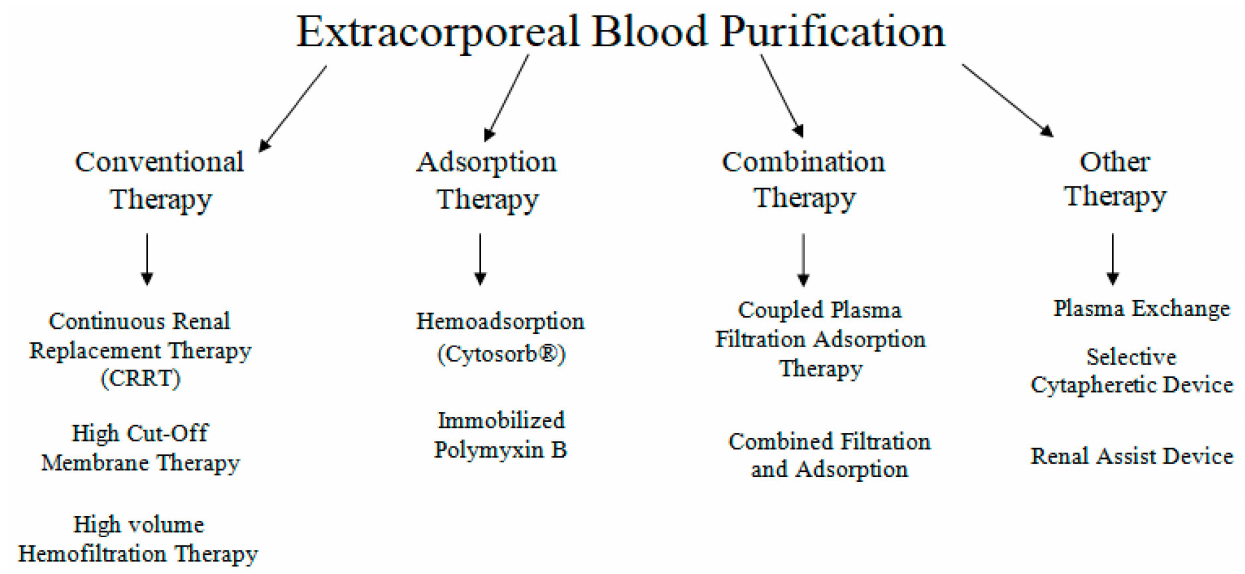
Figure 3. Various available extracorporeal